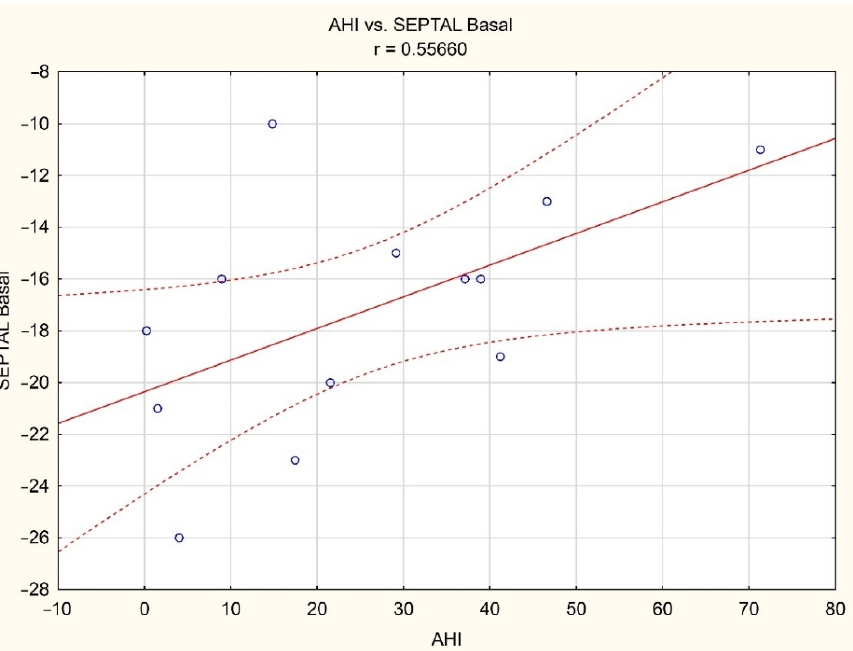
Figure 2. Correlation between AHI and RV basal septal strain in women subgroup (red solid line—estimation curve, dashed lines—95% confidence interval of the estimation curve, small blue circles—individual cases).